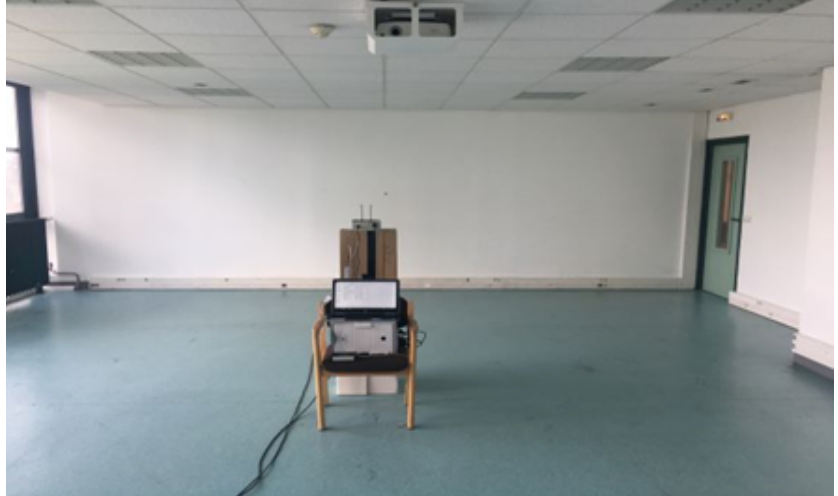
Figure 9. Indoor site of experiments in a classroom.